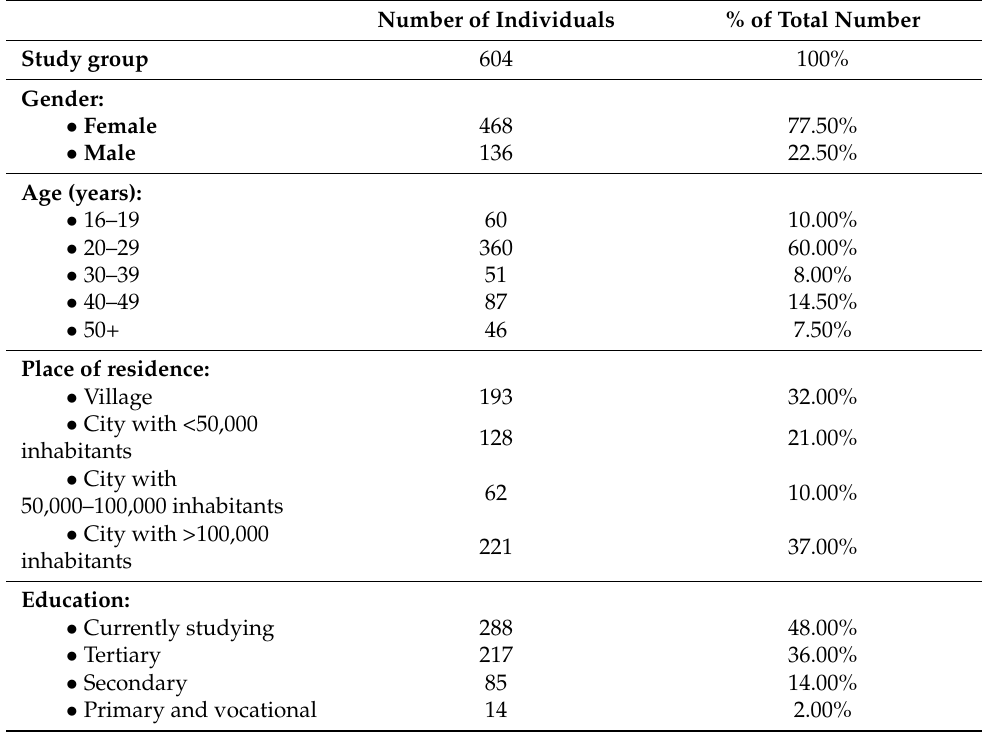
Table 1. Sociodemographic characteristics of the study group. Number of Individuals % of Total Number Study group